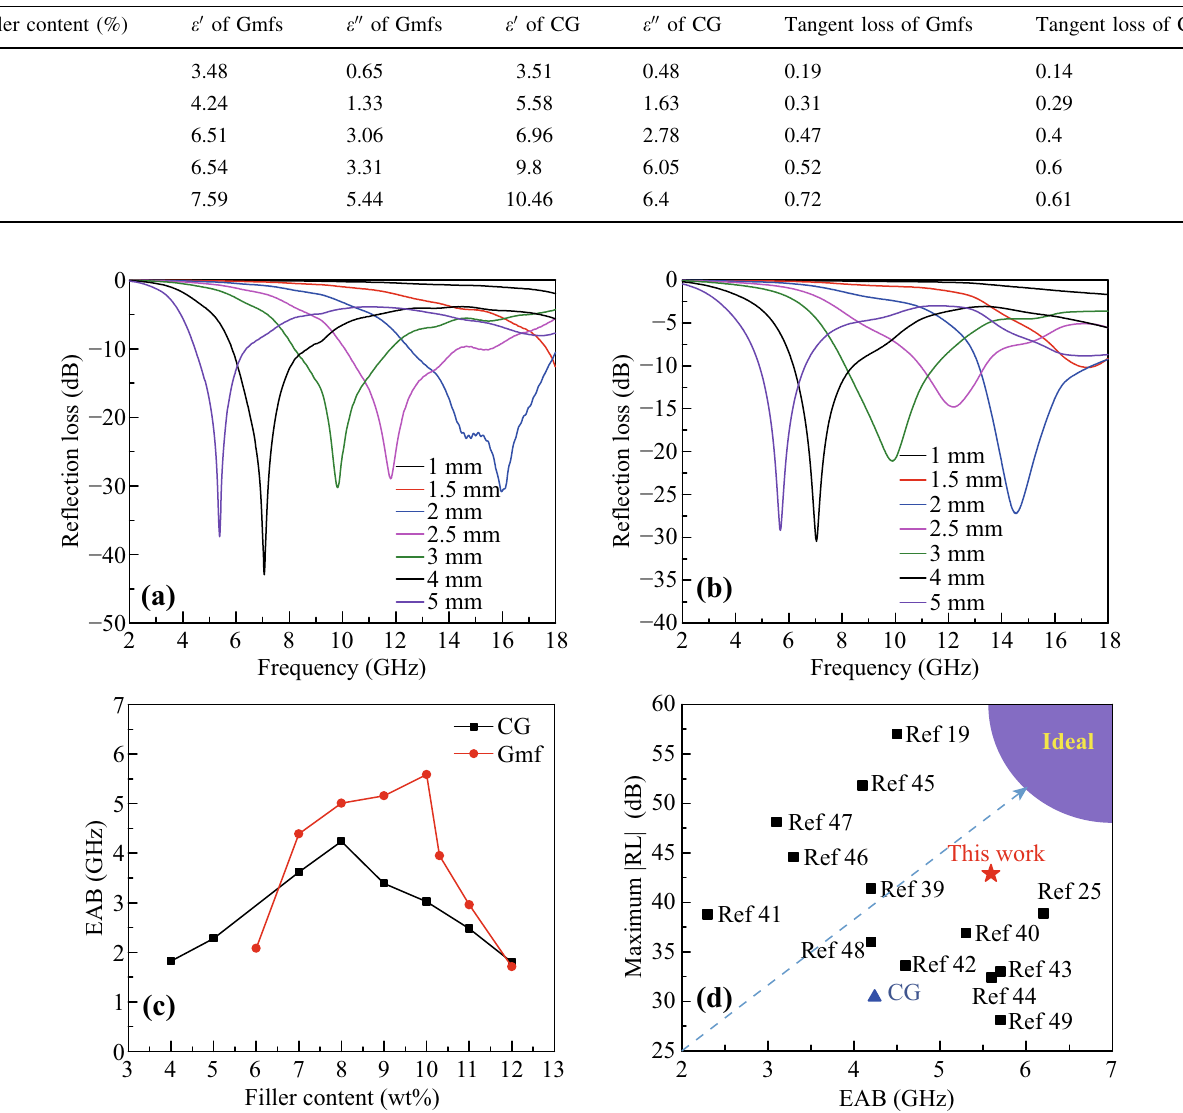
Fig. 4 a Reflection loss of 10 wt% Gmfs/paraffin composite with various thicknesses. b Reflection loss of 8 wt% CG/paraffin composite with various thicknesses. c EABs of Gmfs/paraffin and CG/paraffin under different filler contents. d Comparison of the maximum |RL| and EAB of Gmf/paraffin and CG/paraffin with reported values in